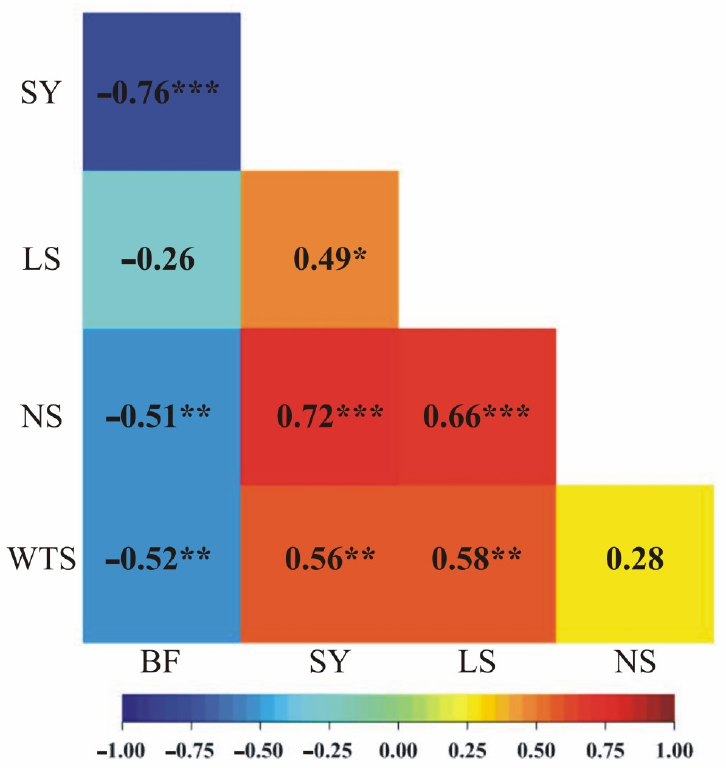
Figure 2. Heatmaps for genotypic correlation coefficients between the observed traits. BF—the beginning of flowering, SY—seed yield, LS—length of silique, NS—the number of seeds per silique, WTS—the weight of 1000 seeds. * p < 0.05, ** p < 0.01; *** p < 0.001.